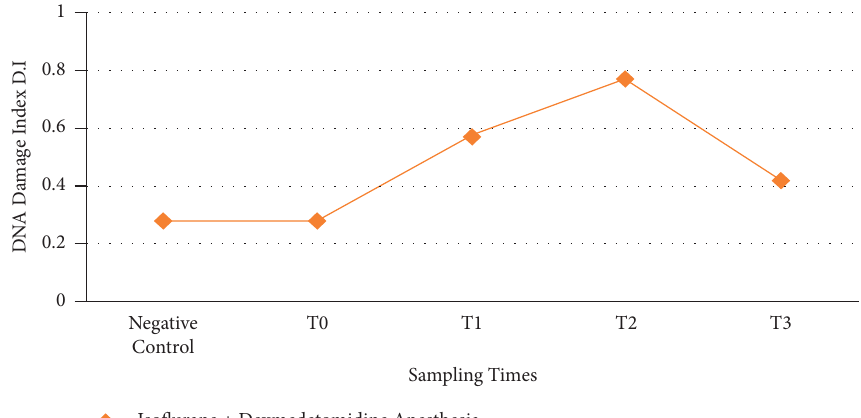
Figure 3: Graphical representation of the genotoxic potential of ISO when used in combination with DEX ( n � 12). T anesthesia induction (baseline), T 1 � at 4hours after anesthesia induction. T 2 � at 8 hours of anesthesia induction, T 3 � at 16hours of anesthesia